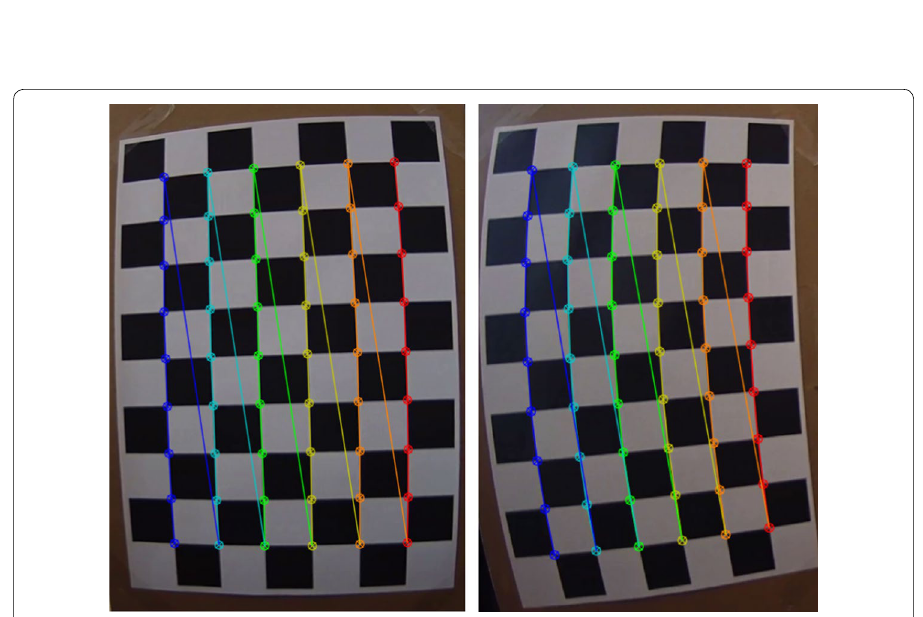
Fig. 11 Demonstration of correcting the image distortion through the use of a